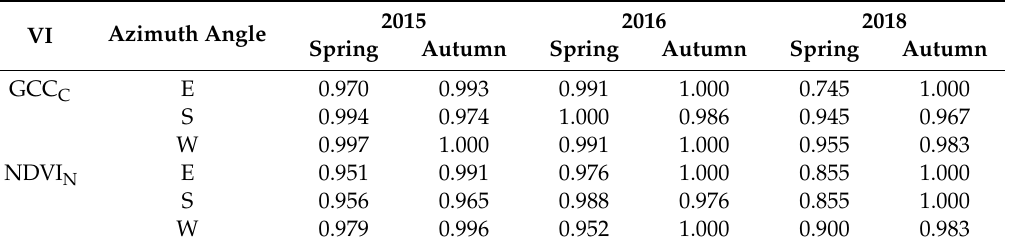
Table 4. Spearman’s rank correlations of vegetation indices at di ff erent azimuth-angles with an inclination angle of 30 ◦